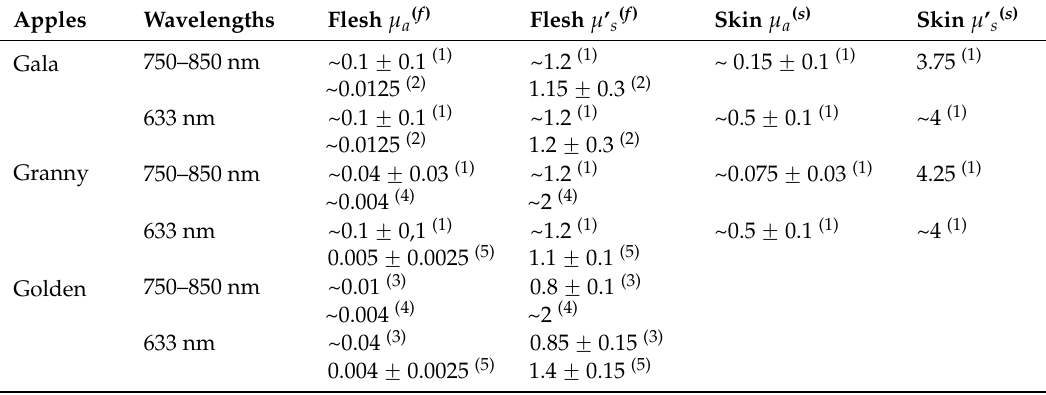
Table 2. Optical properties of studied apple varieties (mm ´ 1